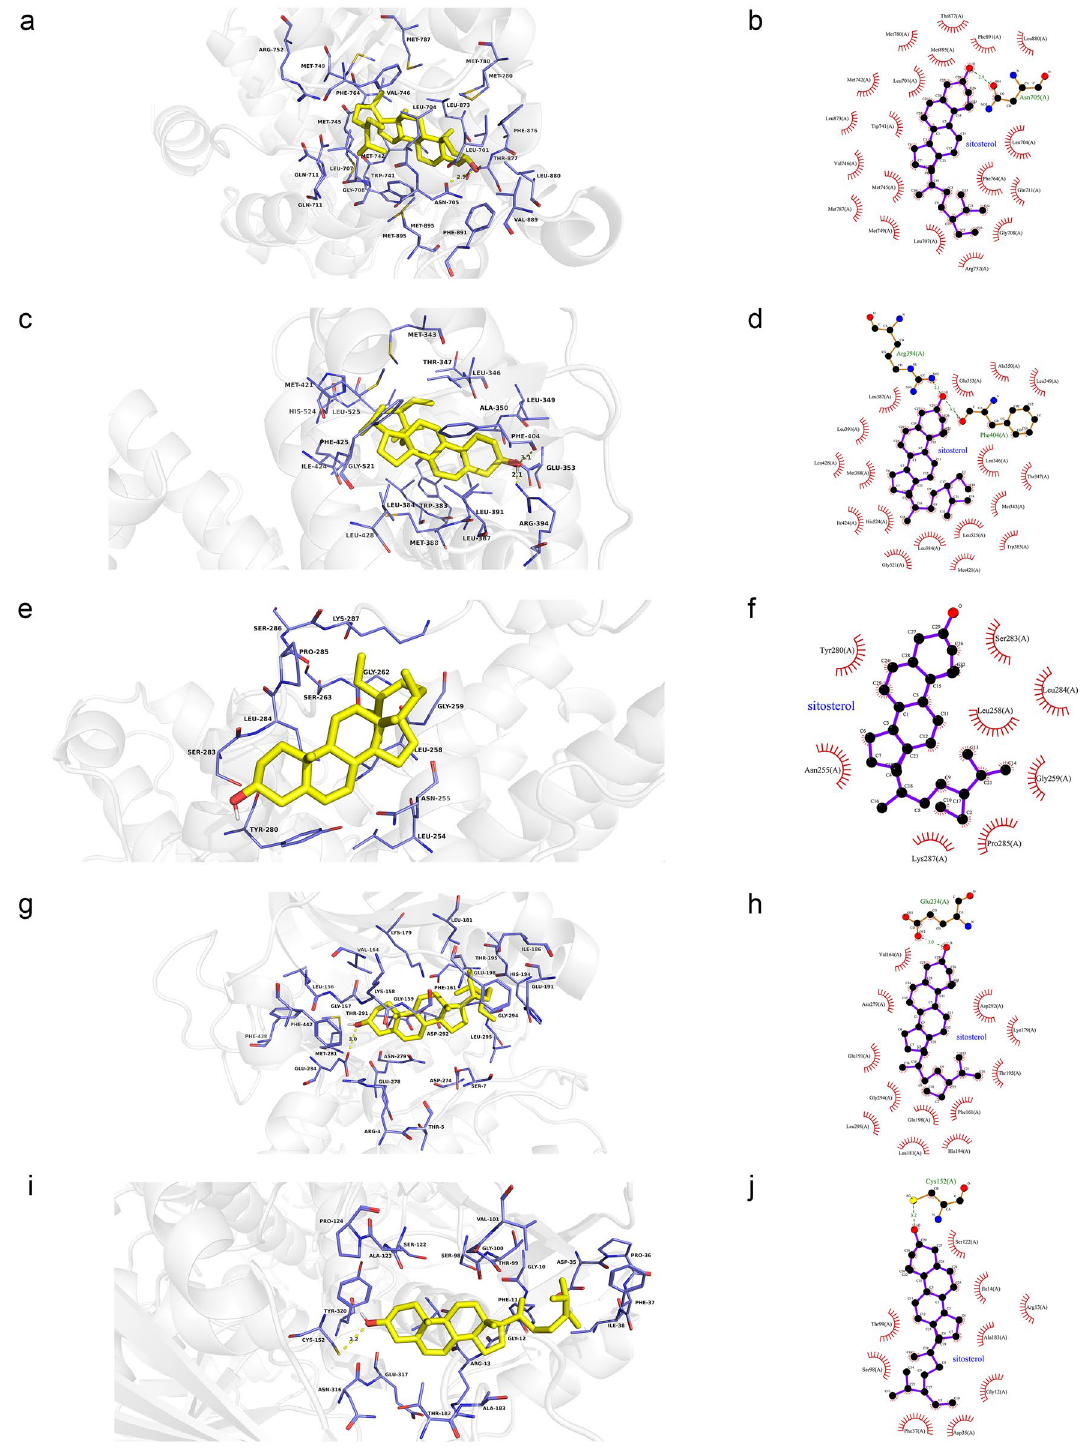
Figure 14. Molecular models of the binding of sitosterol from MO and LB to the predicted targets ( a , b ) AR, ( c , d ) ESR1, ( e , f ) MAPK3, ( g , h ) AKT1 and ( i , j ) GAPDH shown as 3D diagrams and 2D